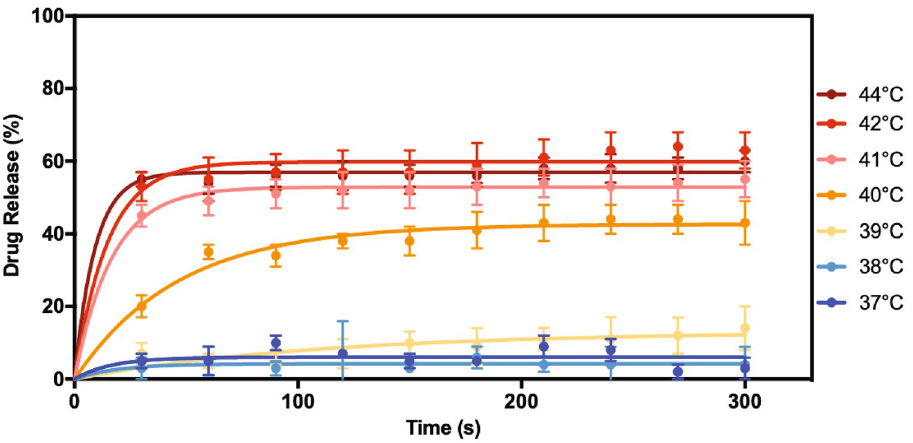
Figure 3. Drug release from thermoLUM incubated at 37–44 °C in 45 mg/mL BSA over 300 s. Samples were collected at 30 s intervals. The liposome-encapsulated drug was separated from unencapsulated drug via size exclusion chromatography. The concentration of LUM was detected via HPLC analysis to determine the amount of drug release from the liposomes at each timepoint. The liposomes were found to release less than 15% of drug over 5 min below 39 °C, while burst release was observed at 41–44 °C. Data shown represent the mean ± SD (n = 3).